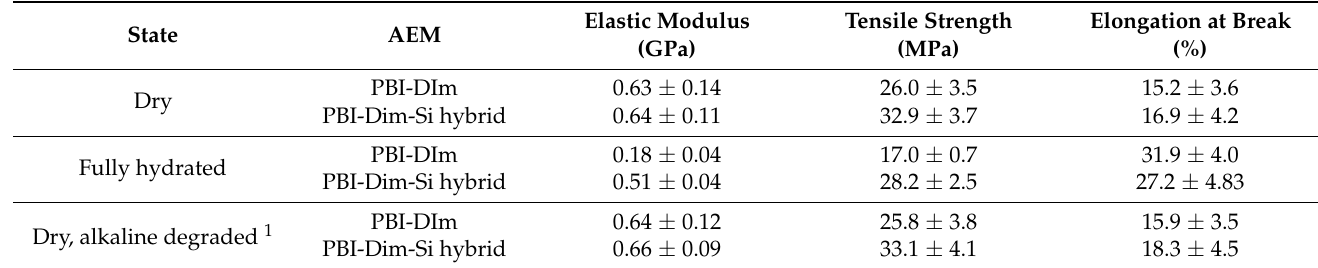
Table 2. Mechanical properties of the PBI-DIm and PBI-DIm-Si hybrid membranes.